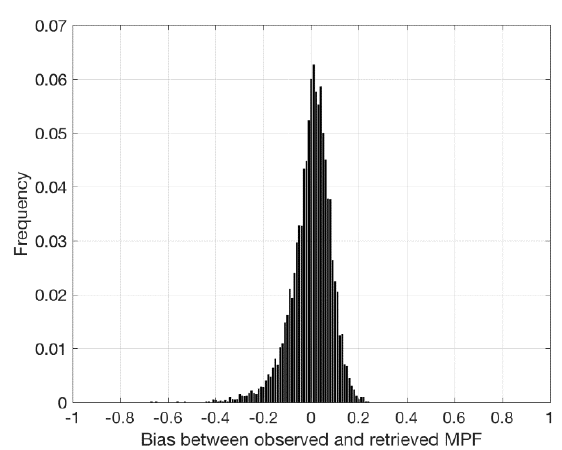
Figure 9. Probability density distribution of the bias between the DNN_MPF and the observed MPF in the 500 m grid for the entire observation period.